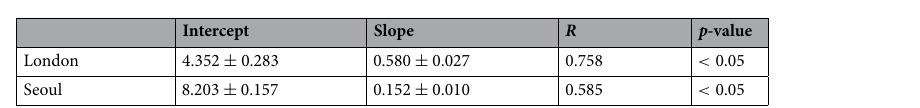
Table 1. Results of linear regressions considering d 1 i as the explanatory variable and ˆ µ i as the response variables. Piccadilly Circus is considered to be the nucleus in London and City Hall in